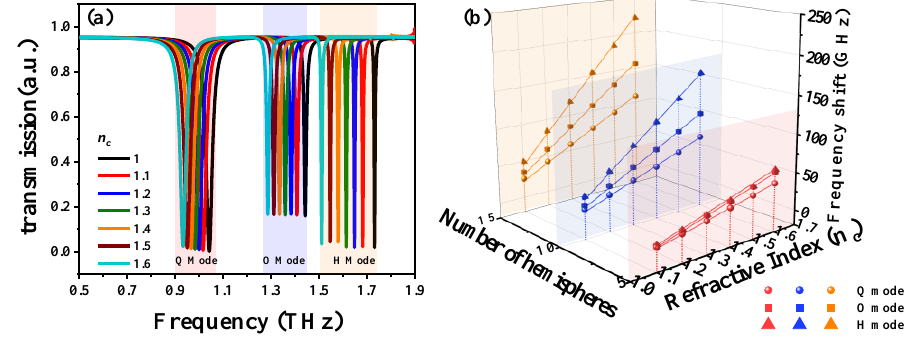
Figure 6. ( a ) Transmission spectra of SSM covered with different hemispheres under the condition of a hemisphere quantity of 15. ( b ) Summaries of the relationships of frequency shifts and n c values and hemisphere quantities.